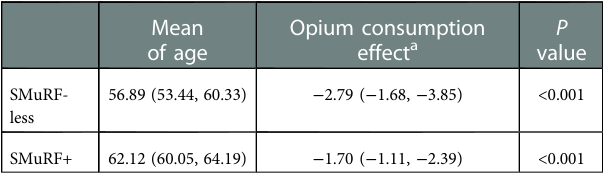
TABLE 5 Association of opium consumption with the age of CABG.